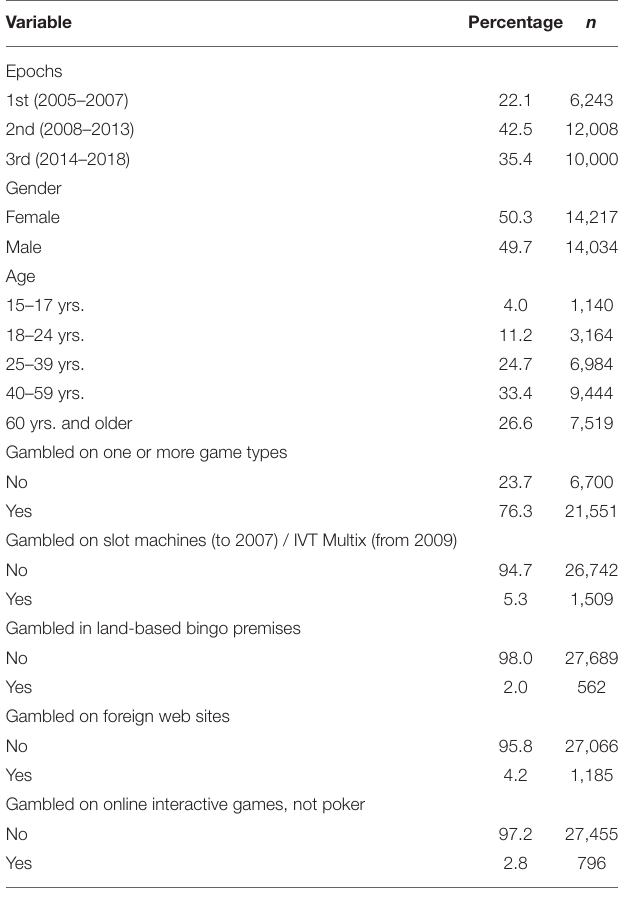
TABLE 1 | Descriptive statistics of study variables ( N =